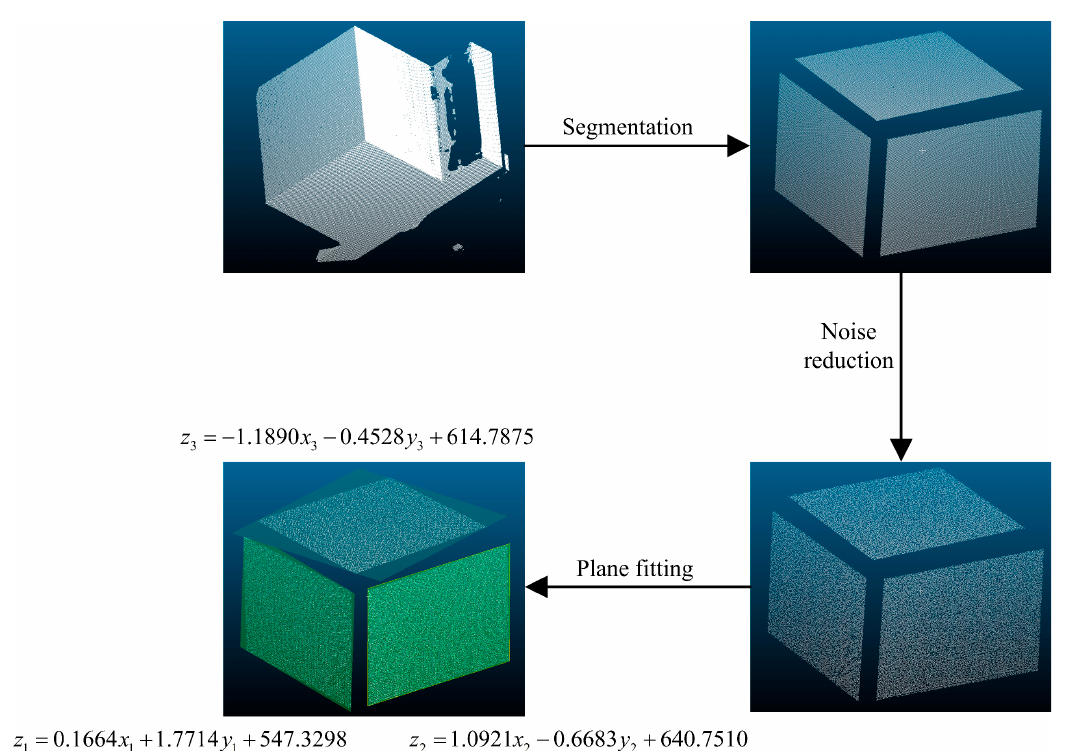
Figure 6. Procedure for the joint sti ff ness identi fi cation.